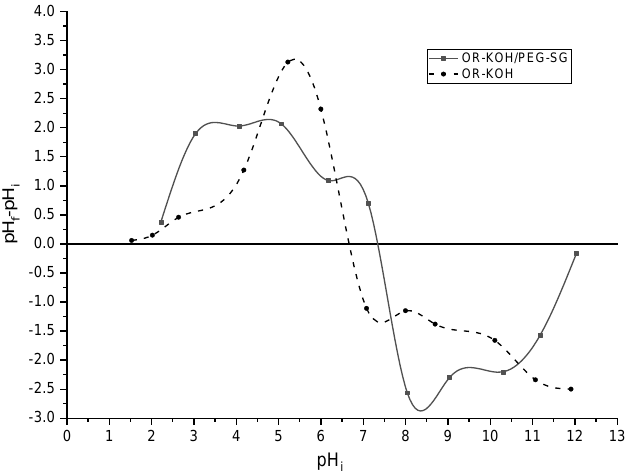
Figure 1. Zero charge points of adsorbents.